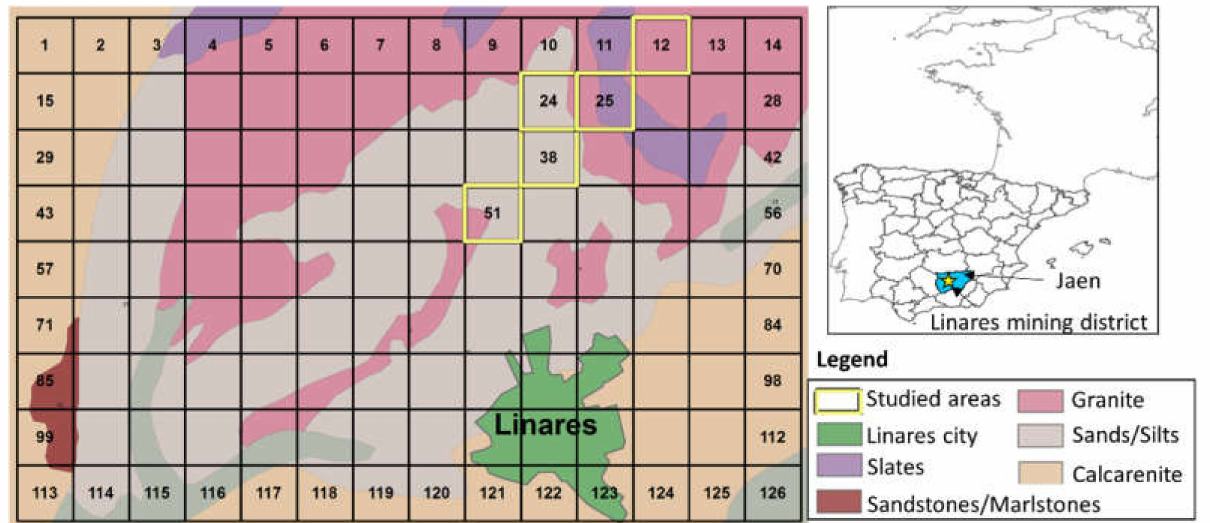
Figure 1. Situation map of the Linares mining district in the province of Jaen (Spain), with outcropping lithology and studied grid squares (1 km 2